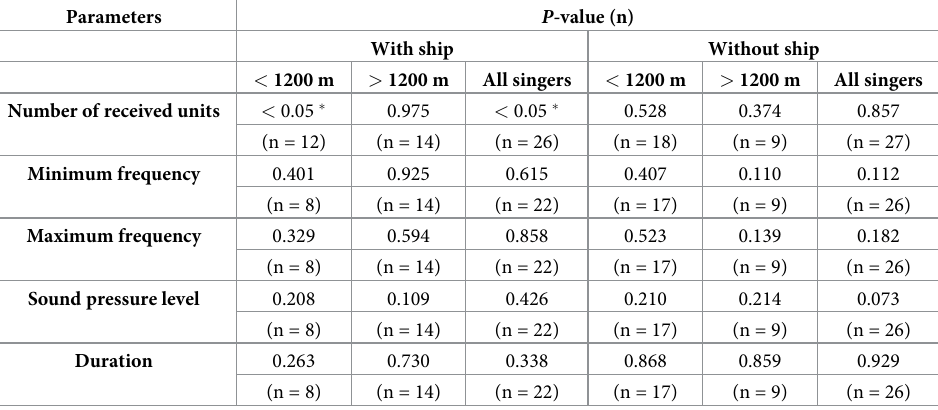
Table 2. The results of comparison of song parameters between pre- and post-test periods. Parameters P -value (n) With ship Without ship < 1200 m > 1200 m All singers < 1200 m > 1200 m All singers Number of received units < 0.05 (cid:3) 0.975 < 0.05 (cid:3) 0.528 0.374 0.857 (n = 12) (n = 14) (n = 26) (n = 18) (n = 9) (n = 27) Minimum frequency 0.401 0.925 0.615 0.407 0.110 0.112 (n = 8) (n = 14) (n = 22) (n = 17) (n = 9) (n = 26) Maximum frequency 0.329 0.594 0.858 0.523 0.139 0.182 (n = 8) (n = 14) (n = 22) (n = 17) (n = 9) (n = 26) Sound pressure level 0.208 0.109 0.426 0.210 0.214 0.073 (n = 8) (n = 14) (n = 22) (n = 17) (n = 9) (n = 26) Duration 0.263 0.730 0.338 0.868 0.859 0.929 (n = 8) (n = 14) (n = 22) (n = 17) (n = 9) (n = 26) P -value and the number of samples (n) used in a Wilcoxon signed rank test are shown in this table. Asterisk indicates that there is a significant difference between pre- and post-test